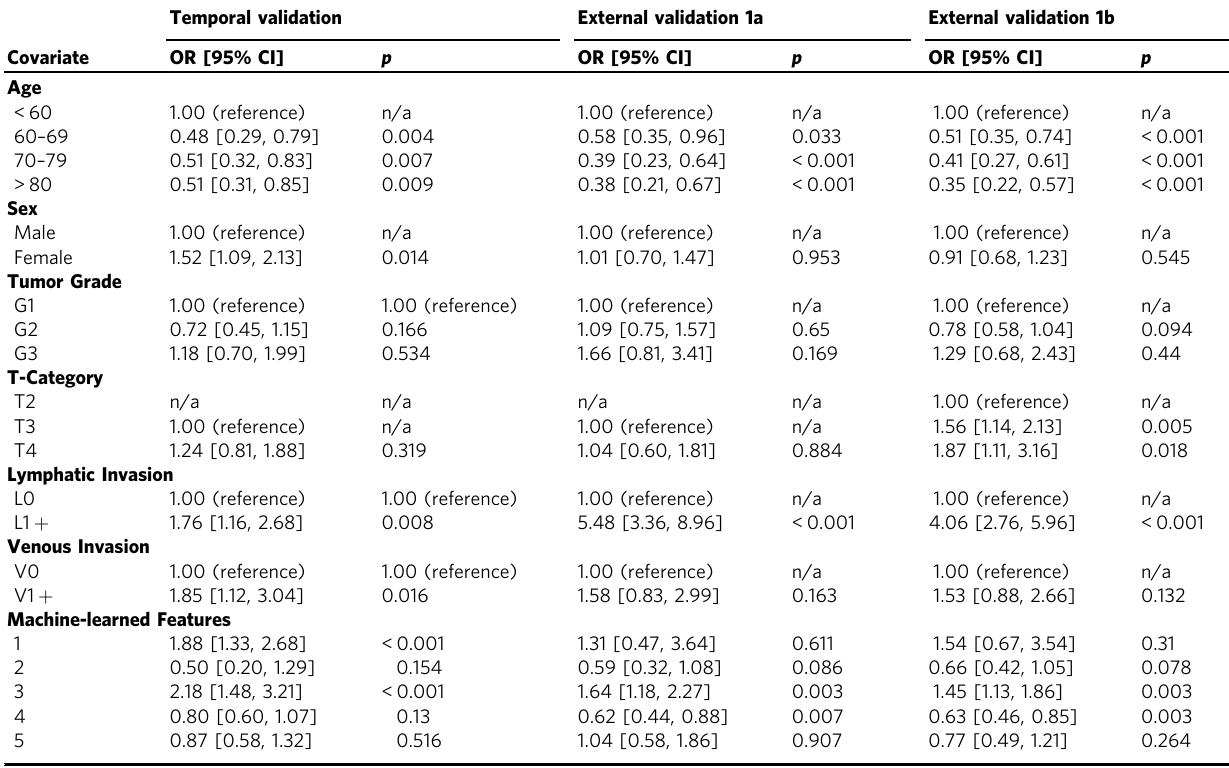
Table 2 Multivariable odds ratios for the machine-learned features